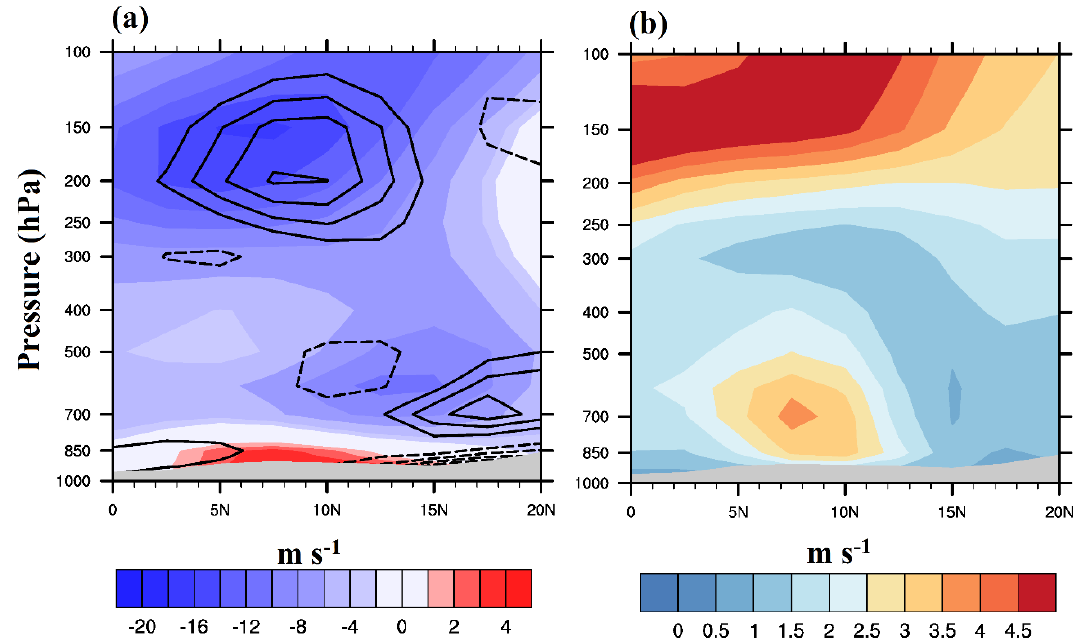
Figure 3. Climatological mean of JJAS ( a ) zonal wind (m s − 1 ; shaded) and divergence (m s − 1 ; contours) and ( b ) standard deviation of zonal wind. Values under the topography are masked gray.